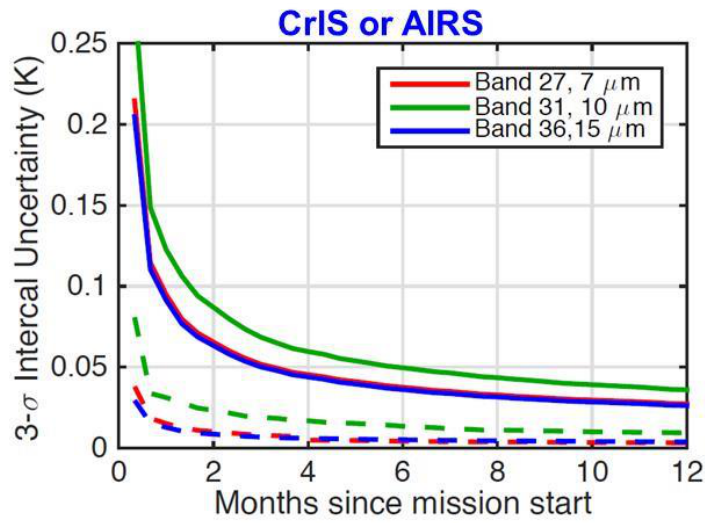
Figure 28. Simulated Intercalibration Uncertainty (IU) as a function of time since mission start for a single CLARREO polar orbit with 50 km IR footprints and 20 seconds between samples.